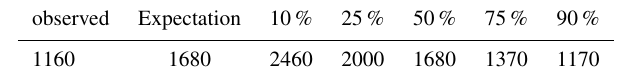
Table 3. Observed and predicted monthly discharge (m 3 s − 1 ) of July 1999 at the Haerbin station.